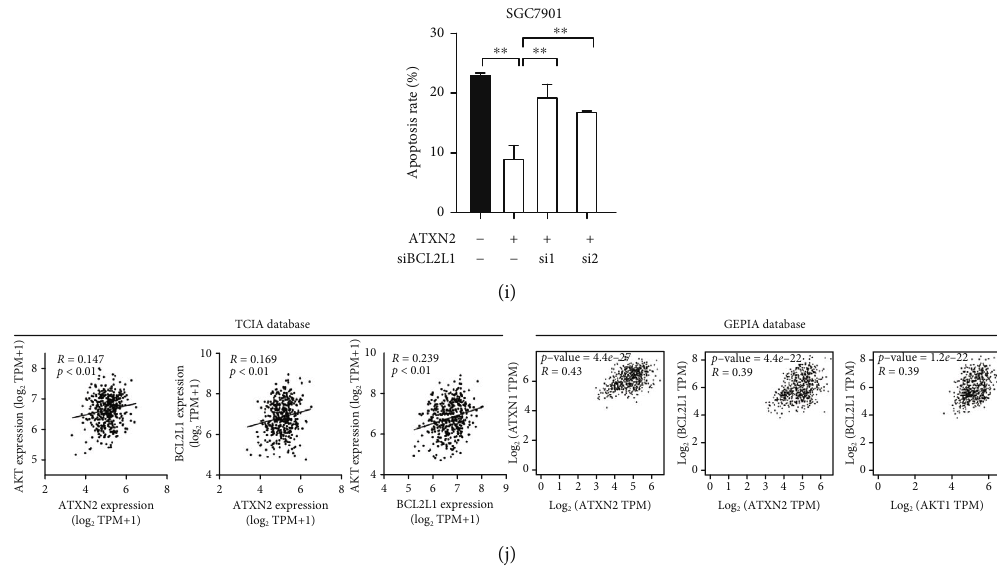
Figure 3: ATXN2 activated the PI3K/AKT pathway. (a) Heatmap of altered genes when ATXN2 was downregulated in SGC7901/5-FU cells. (b) KEGG pathway analysis of changed pathways when ATXN2 was downregulated in SGC7901/5-FU cells. (c) Phosphorylation levels of PI3K and AKT were measured by Western blot. (d) Protein levels of p-AKT and AKT in SGC7901 cells overexpressing ATXN2 or treated with an AKT inhibitor. (e) Apoptosis rates of SGC7901 cells overexpressing ATXN2 or treated with an AKT inhibitor were detected after treatment with 5-FU (10 μ g/mL). (f) Downregulated genes enriched in the PI3K/AKT pathway. (g) Protein level of BCL2L1 in SGC7901 cells and SGC7901/5-FU cells. (h) Protein level of BCL2L1 in SGC7901 cells overexpressing ATXN2 and/or silencing BCL2L1. (i) Apoptosis rates of SGC7901 cells overexpressing ATXN2 or (and) silencing BCL2L1 were detected after treatment with 5-FU (10 μ g/mL). (j) The correlation between ATXN2, AKT, and BCL2L1 expression in the TCIA and GEPIA databases. ∗∗ P < 0 : 01